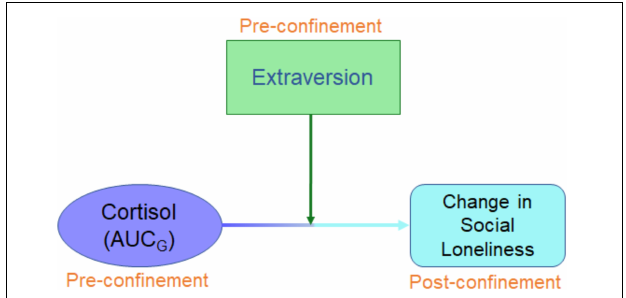
FIGURE 1 | Conceptual diagram of working hypothesis. Influence of pre-pandemic cortisol on change in social loneliness will be moderated by